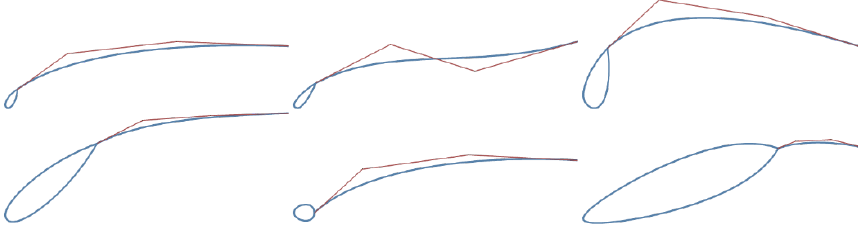
Figure 15. Examples of mast/sail sections that can be generated by the parametric CAD module.